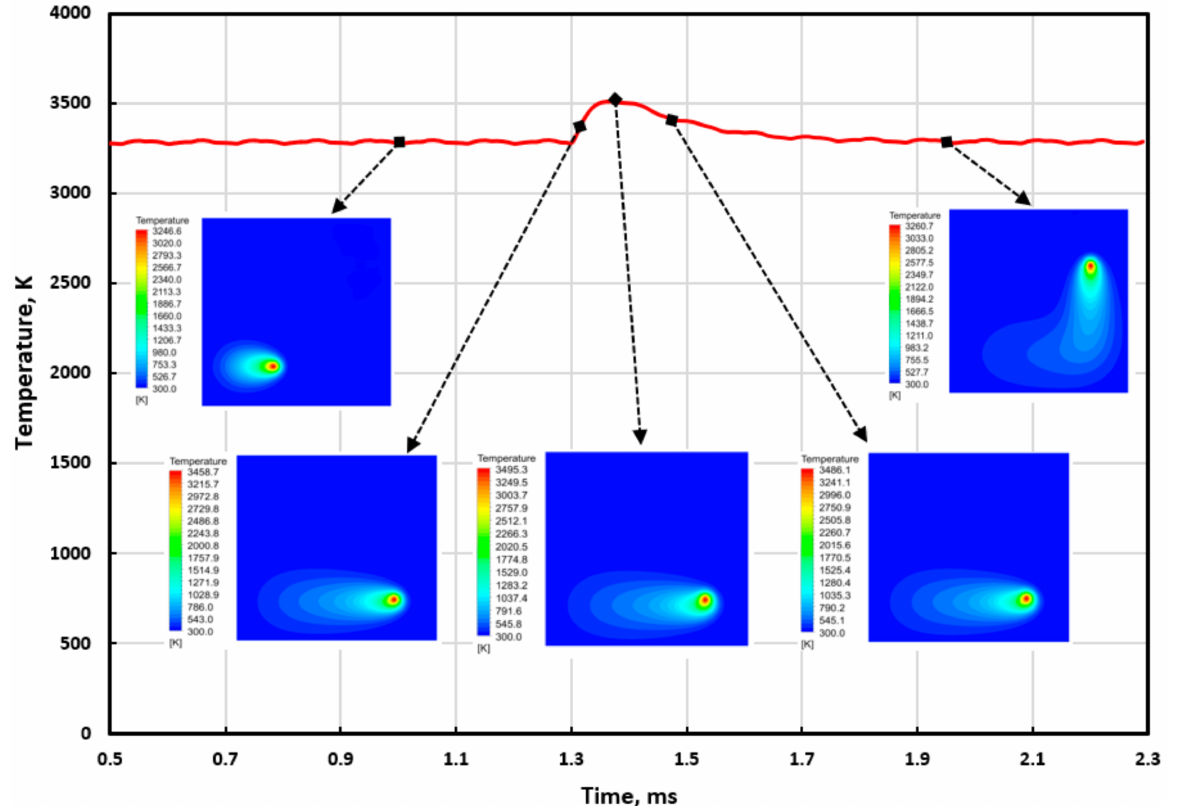
Figure 13. The peak occurring in the temperature history of the concentric in–out strategy when the laser source was changing its direction.